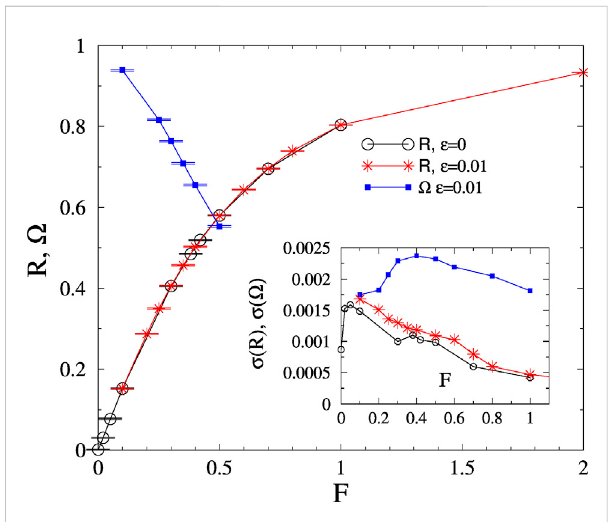
Order parameter dependence on F for the KKI-113 for the noisy and the noiseless cases at K = 1. Inset: Variances of R and Ω for the noisy case.